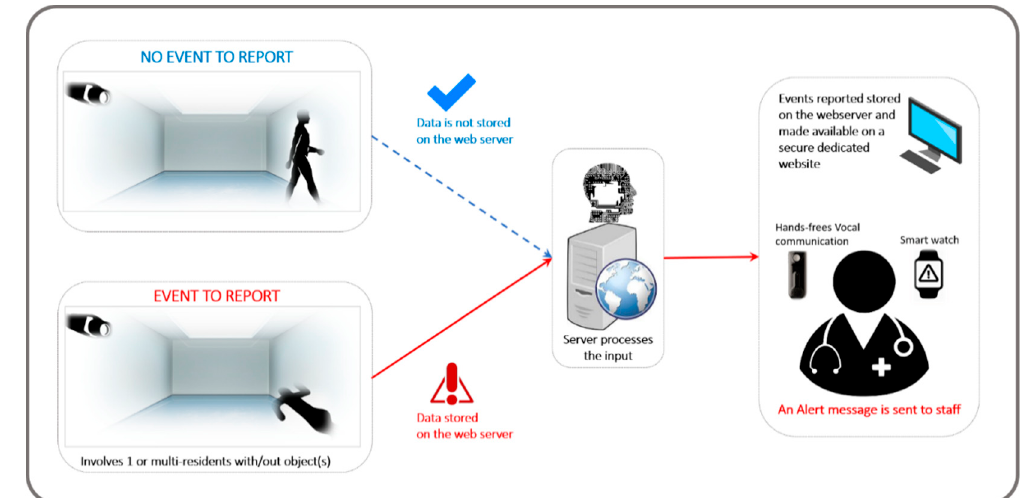
Figure 1. Graphical representation of the internal logic of the behavioural disturbances